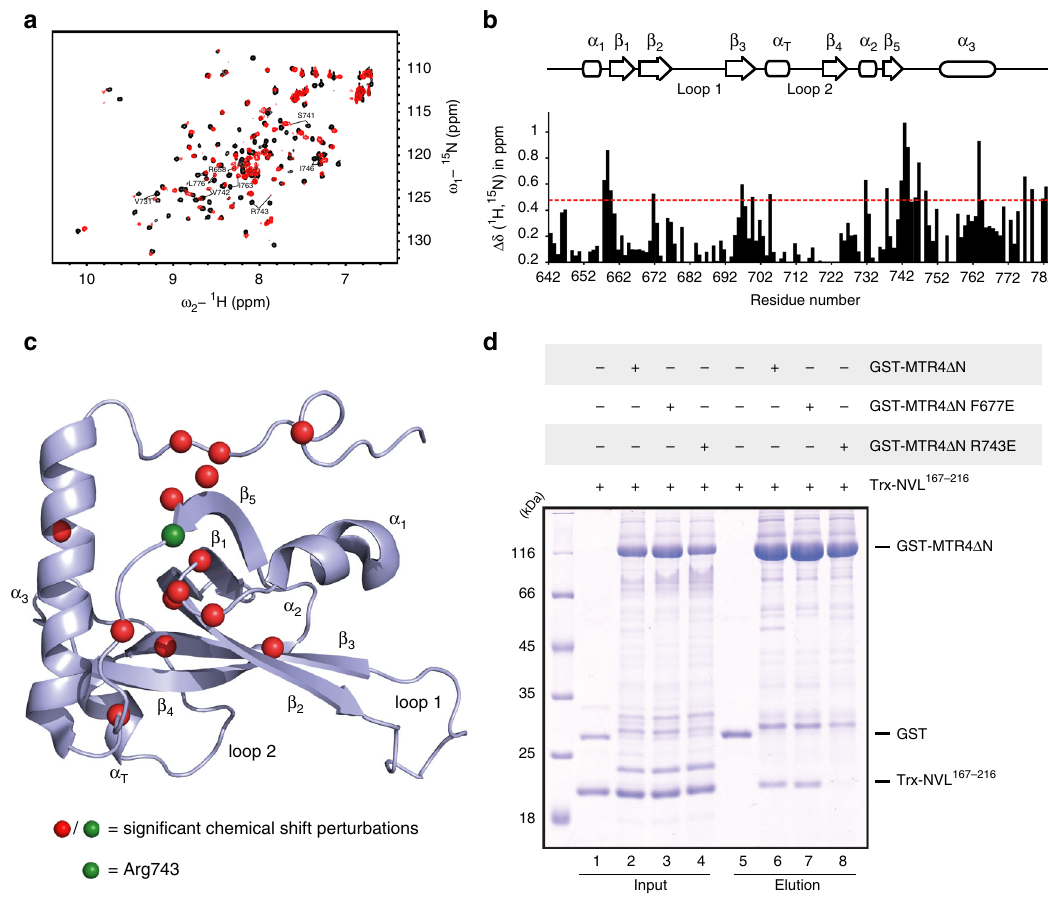
Fig. 2 Analysis of MTR4 KOW-NVL complex by NMR and site directed mutagenesis. a Overlay of 1 H- 15 N-HSQCs of either MTR4 KOW alone (black) or in complex with a six-fold excess of NVL2 (red). Selected residues experiencing large chemical shift perturbations (CSPs) are labeled. b Plot of CSPs per residue of the MTR4 KOW sequence. The red line marks the threshold of signi fi cant CSPs, which are mapped on the model of MTR4 KOW (PDB 6IEH) in panel c. Gaps indicate either prolines or residues that could not be assigned. c MTR4 KOW domain (PDB 6IEH) with labeled secondary structural elements as assigned by NMR and residues showing signi fi cant CSPs (displayed as red/green spheres). d Protein co-precipitations by pull down assays. GST-tagged MTR4 Δ N (WT or mutants) were incubated with Trx-NVL 167 – 216 before co-precipitation with glutathione sepharose beads. A total of 3% of the input (lanes 1 – 4) and 30% of the eluates (lanes 5 – 8) were analyzed on 15% SDS-PAGE gels and visualized by staining with coomassie brilliant